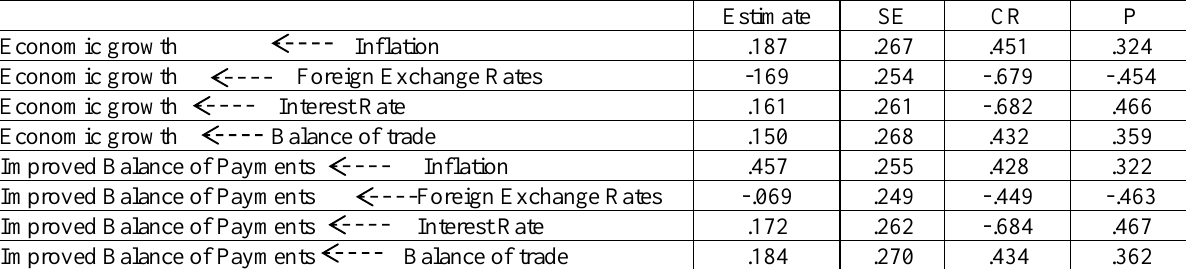
Table 2. Composite Model Regression Weights